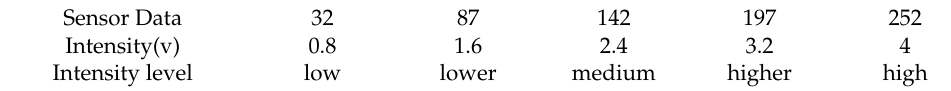
Table 2. Correspondence between sensor data and tactile intensity, Intensity level.